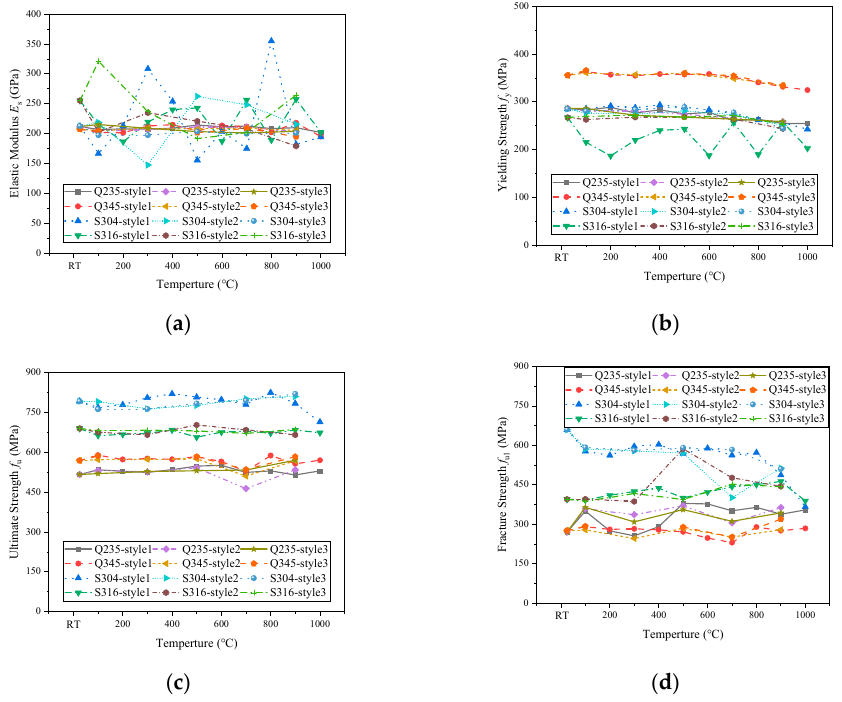
Figure 5. Basic features of structural steels. ( a ) Elastic modulus; ( b ) Yielding strength; ( c ) Ultimate strength; ( d ) Fracture strength.